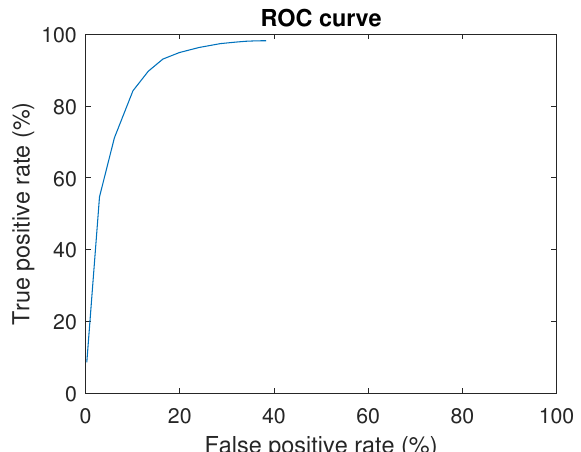
Figure 6. The receiver operating characteristic (ROC) curve for variant neighborhood window sizes, 5 ≤ M ≤ 125, and their